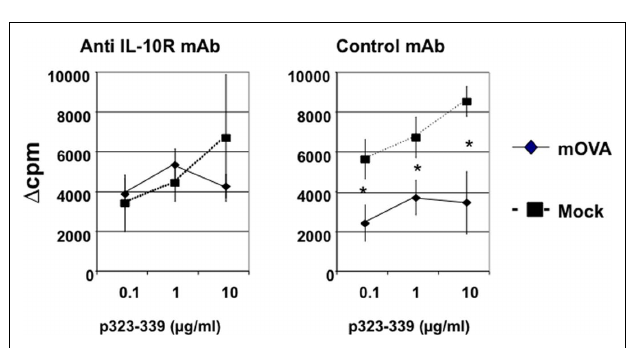
FIGURE 4 | IL-10 produced by the host is required for tolerance induction by transgenic tolerogenic B cells. One × 10 7 B LPS-activated mOVA or wt B cells were injected into wt C57BL/6 mice.Tolerance induction protocol, anti-IL-10R treatment, and assay method are same as described in Figures 1 and 3 ( n = 4). Data are representative of two independent